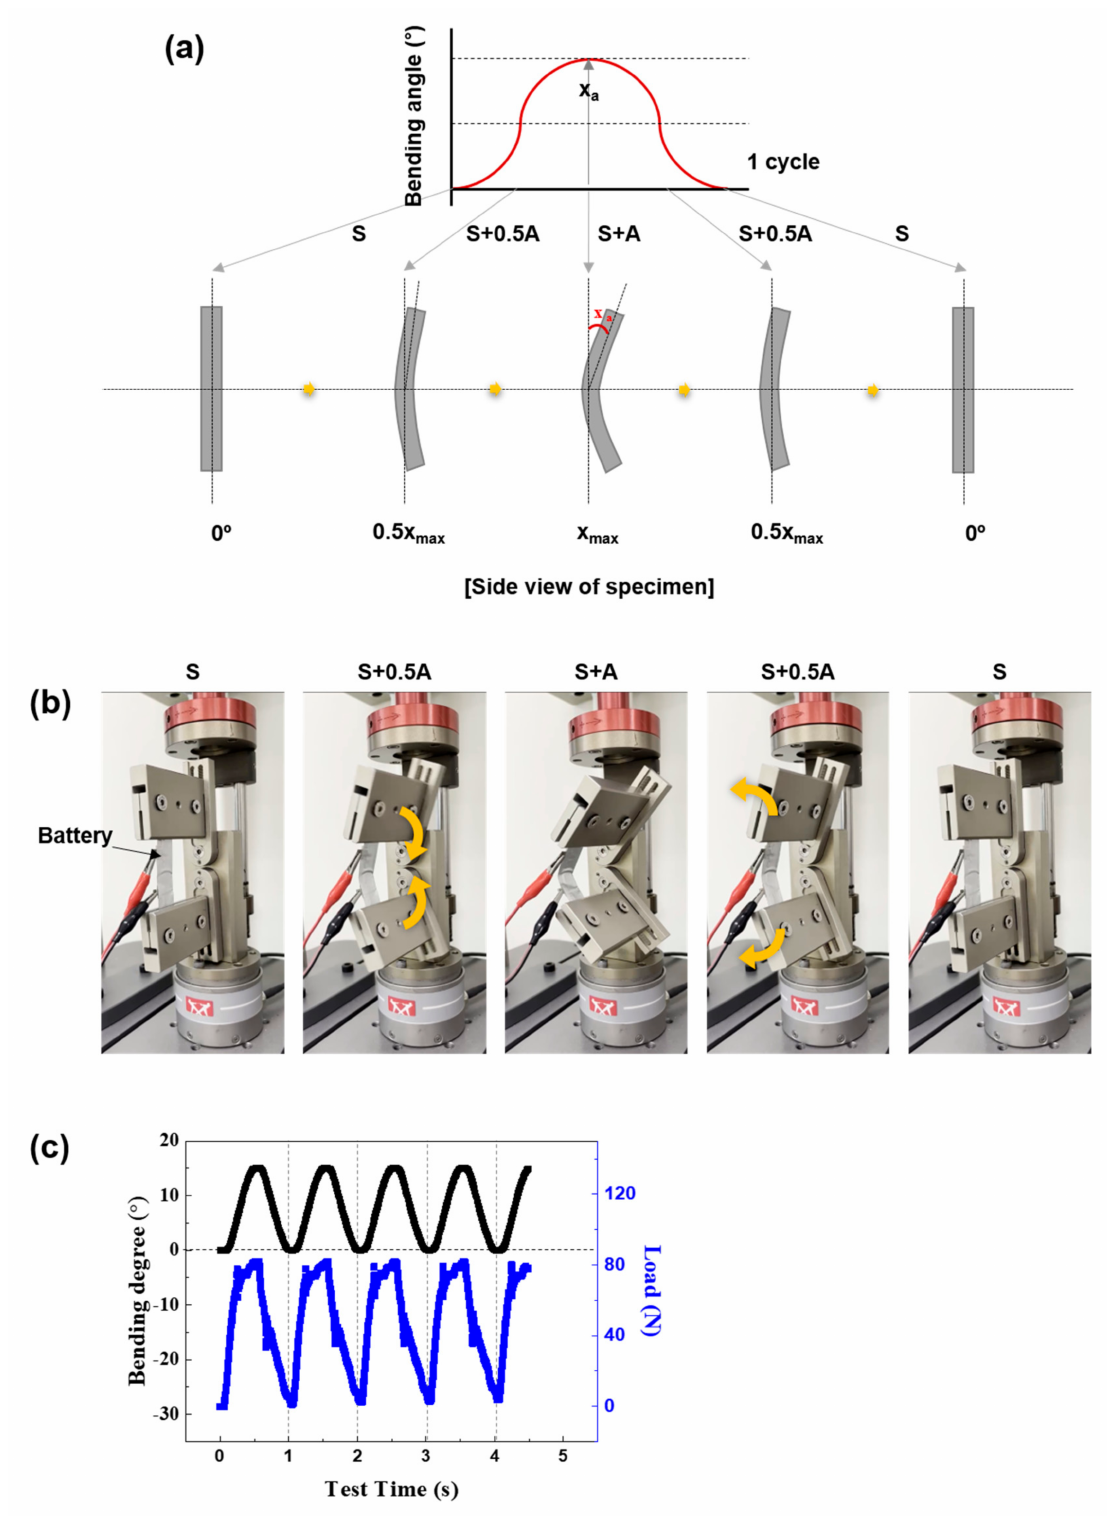
Figure 3. The bending fatigue test conditions: ( a ) scheme of the phase changes in a sinusoidal wave, ( b ) bending testing machine portraying the flexible conditions, and ( c ) fatigue load changes based on the rotation of the